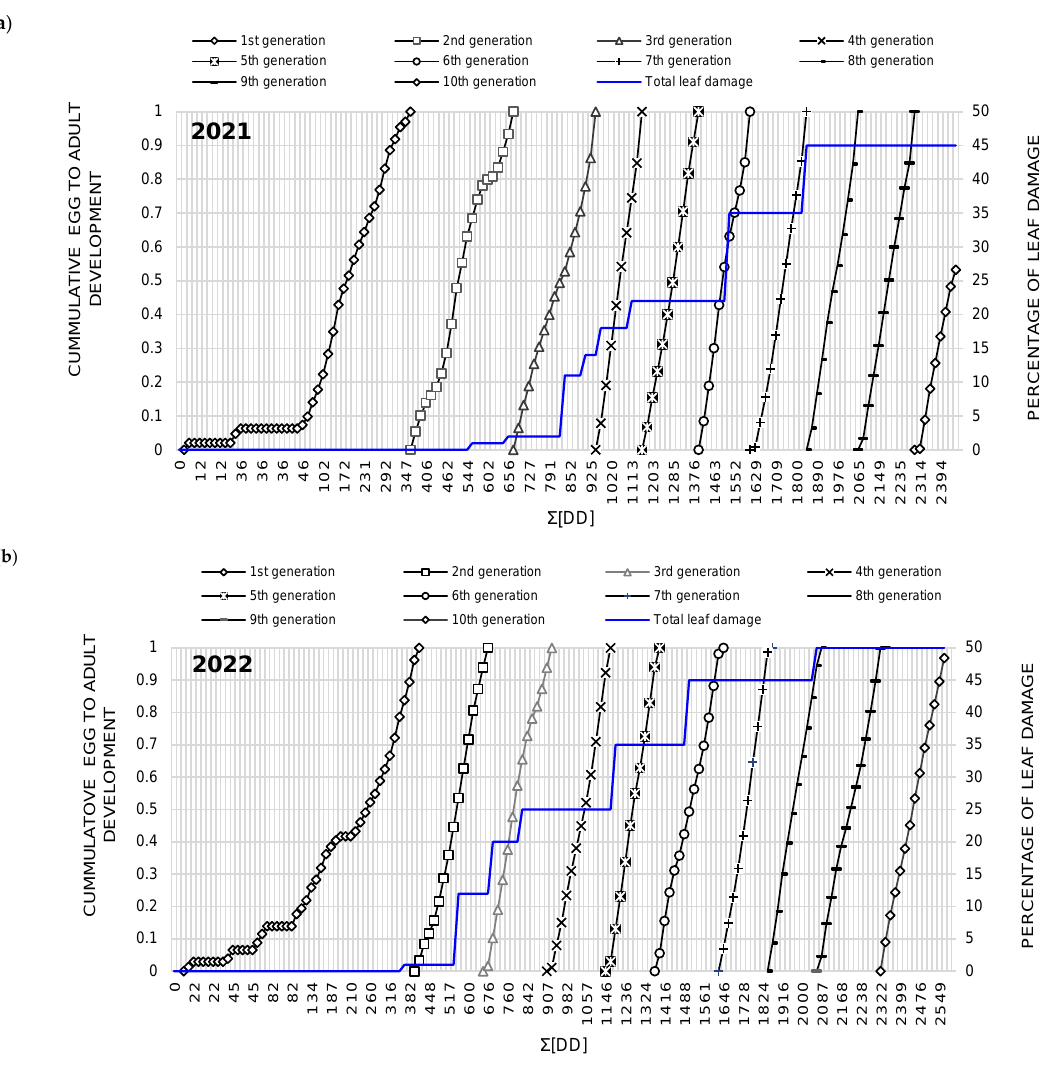
Figure 4. Simulated total egg-to-adult development of T. urticae and succession of generations according to the developmental rate summation model output scaled over the linear heat summations (degree days) and comparison with actual plant damage caused by T. urticae in dry bean during 2021 ( a ) and 2022 ( b ). Table 2. Degree-day developmental heat summation risk thresholds of total egg to adult T. urticae development in respect to corresponding predictions generated by the developmental rate summa- tion model.